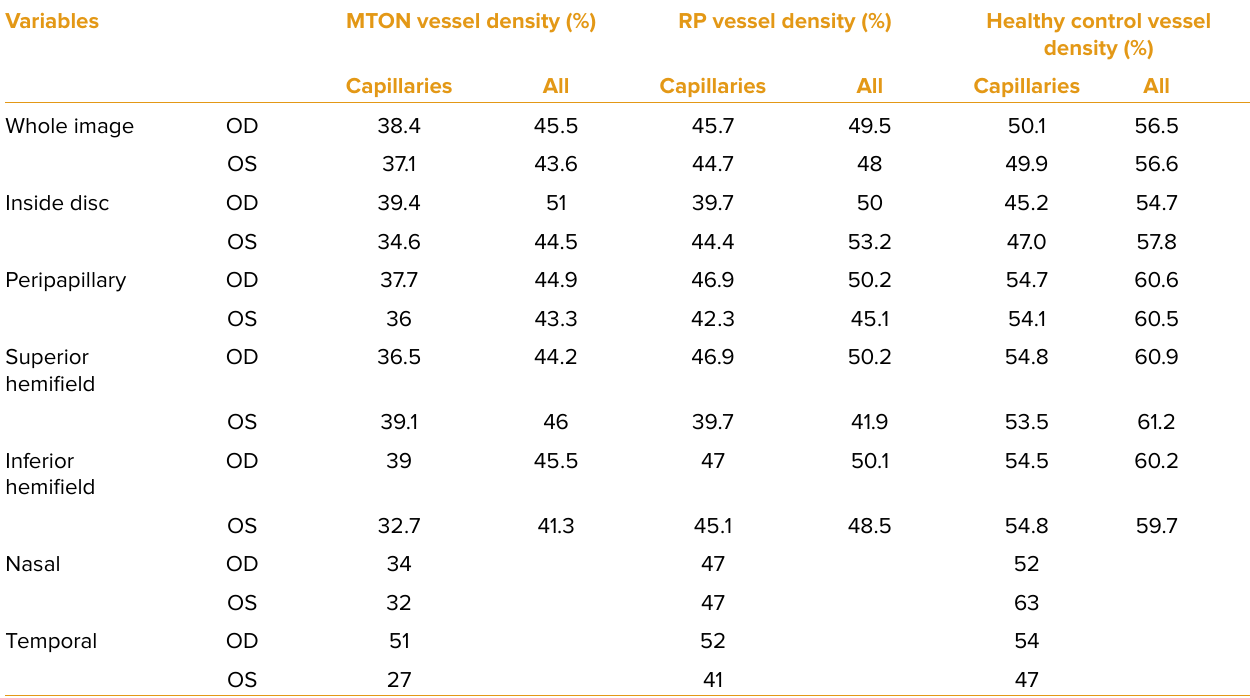
Table 1. Peripapillary OCT-A parameter in MTON, RP, and healthy control